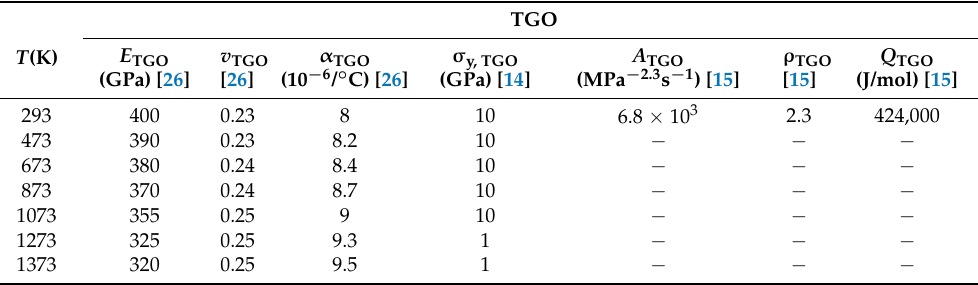
Table 3. Material properties of TGO.